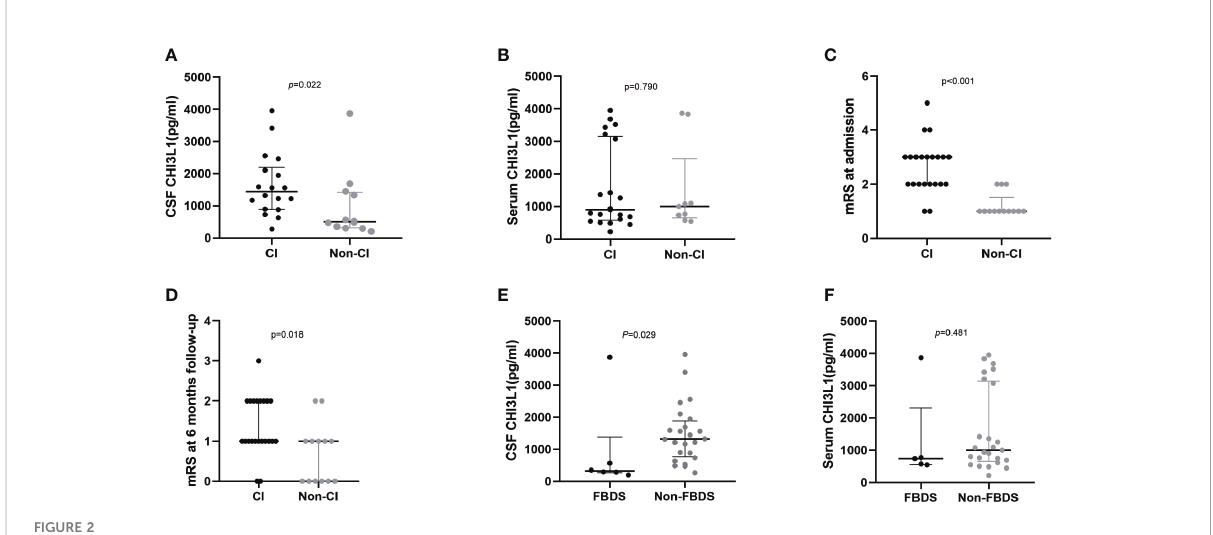
FIGURE 2 CHI3L1 level difference in serum and cerebrospinal fl uid of LGI1 patients with different clinical presentations. Cerebrospinal fl uid (A) and serum (B) CHI3L1 levels in anti-LGI1 encephalitis patients with and without cognitive impairment; mRS scores at admission (C) and at 6-month follow- up (D) of anti-LGI1 antibody encephalitis presenting with cognitive impairment and those without cognitive impairment symptomes; Cerebrospinal fl uid (E) and serum (F) CHI3L1 levels in anti-LGI1 encephalitis patients presenting with only FBDS and other symptoms; CI: Patients presenting with cognitive impairments, Non-CI: Patients presenting without cognitive